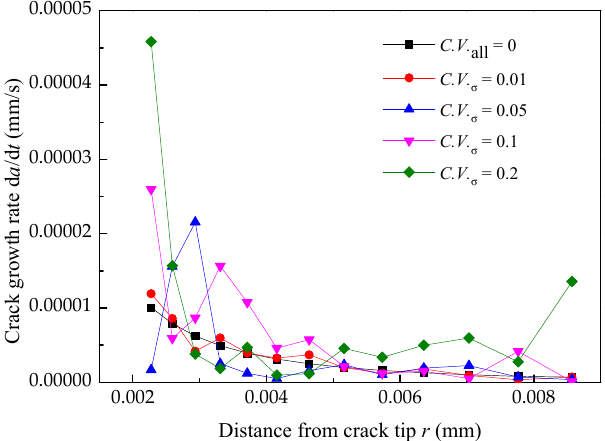
Figure 10. Crack growth rate under different Yield strength distribution.